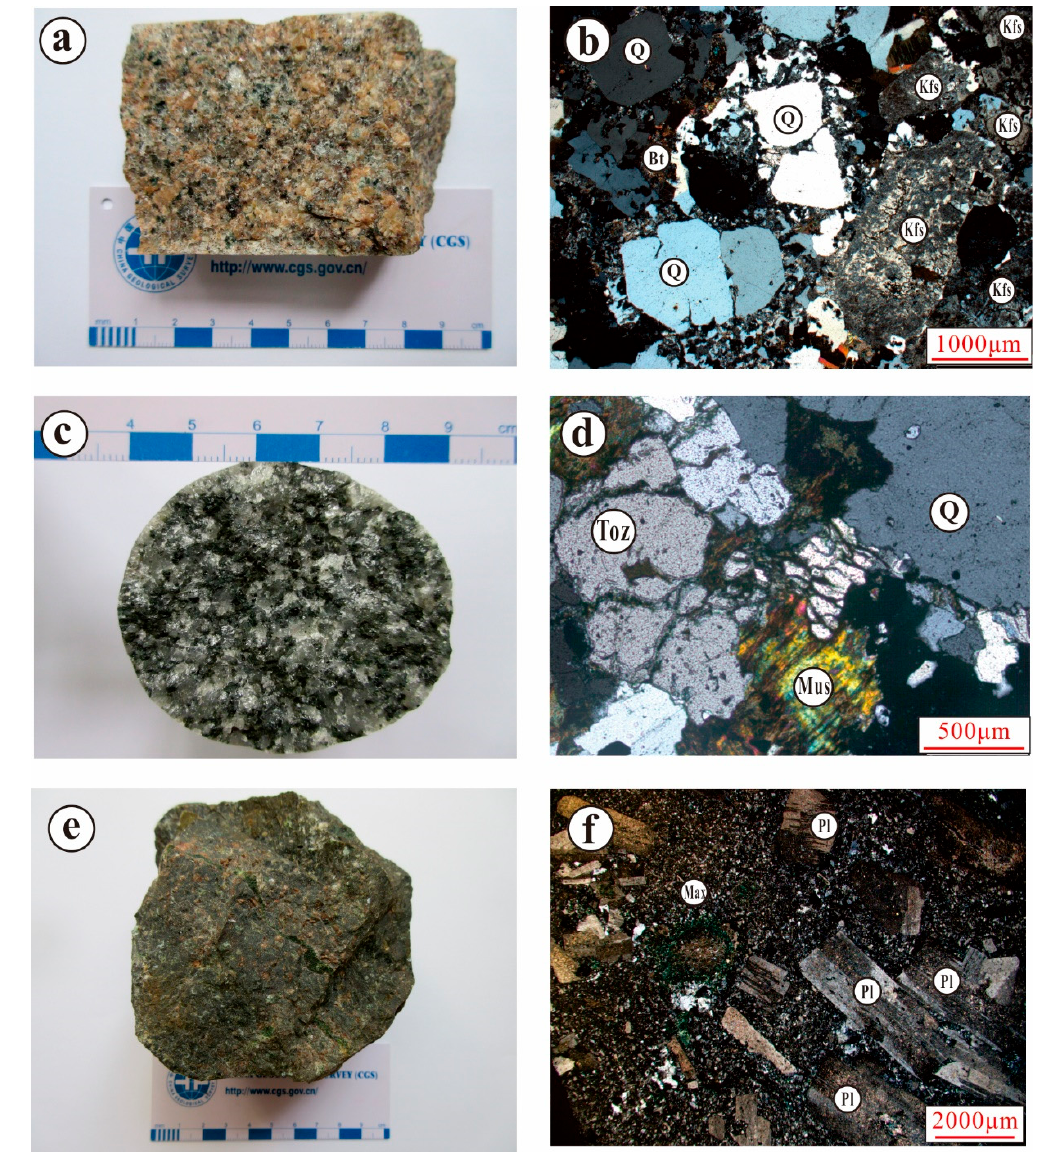
Figure 4. ( a , c , e ) Photographs and ( b , d , b ) Photomicrographs (under crossed polar) of intrusive-volcanic rocks in Tiantangshan tin polymetallic deposits: ( a ) and ( b ) are alkali-feldspar granite; ( c ) and ( d ) are greisen; and ( e ) and ( f ) are trachydacite. Kfs, K-feldspar; Q, quartz; Bt, biotite; Toz, topaz; Mus, muscovite; Pl, plagioclase; Max, matrix.